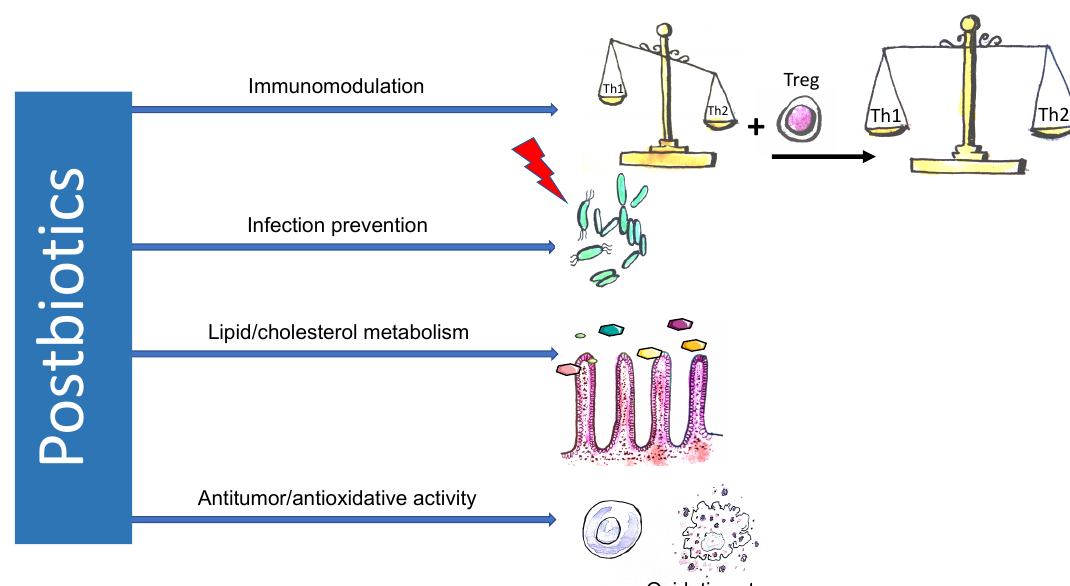
Figure 3. Mechanisms of action of postbiotics. Postbiotics display pleiotropic properties. Due to the induction of differentiation of T regulatory lymphocytes and synthesis of anti-inflammatory cytokines, postbiotics restore the imbalance between two major arms of immune system represented by Th1 and Th2 lymphocytes. The balance between Th1 and Th2 lymphocytes is vital for immunoregulation, and its disturbance causes various immune diseases, including atopic disorders. Antibacterial activity is probably mediated by postbiotics’ impact on the molecular structure of enterocytes, which results in sealing the intestinal barrier. “Statin-like” activity of postbiotics and its future therapeutic application in metabolic and related diseases is highly anticipated.